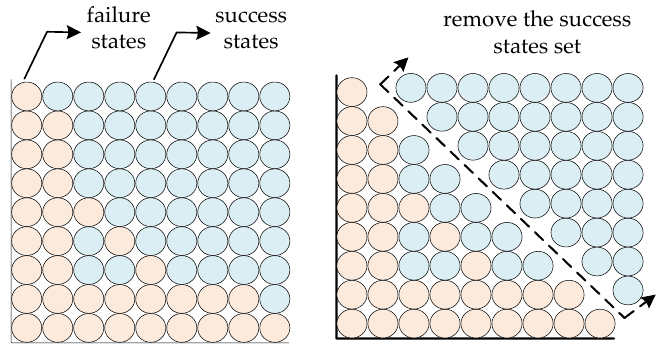
Figure 4. The schematic diagram of Intelligent State Space Reduction (ISSR) algorithm.